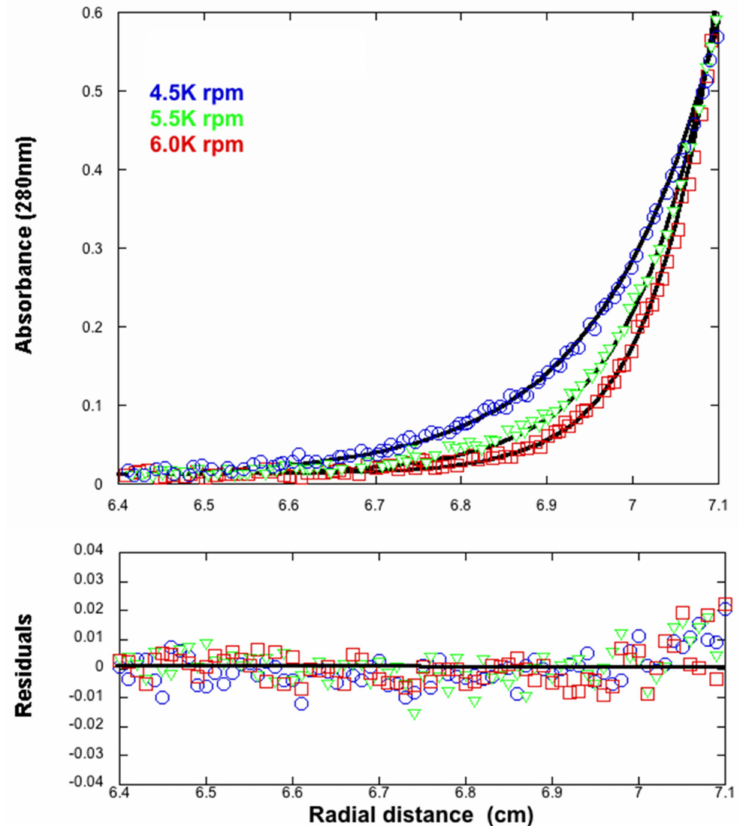
Figure 3. Sedimentation equilibrium centrifugation of gp11. Rotor speeds were 4.5, 5.5, and 6.0 kRPM. Protein concentration was 0.016 mg/mL (0.353 µ M of a 45 kDa monomer). In solution, gp11 has an apparent molecular weight of 443 kDa, about ten times the monomeric